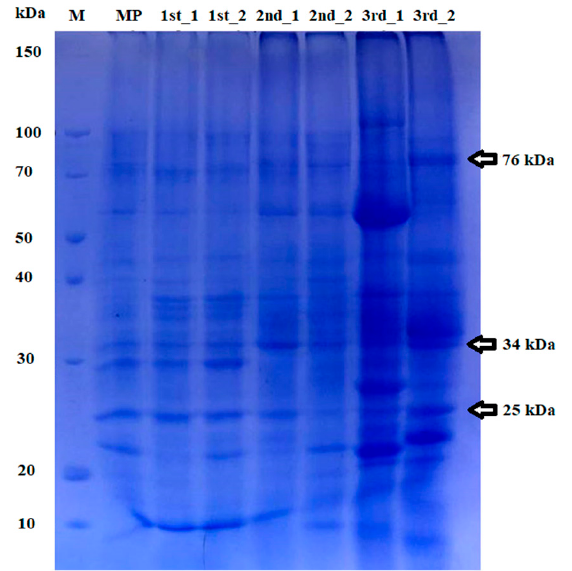
Figure 4. SDS-PAGE analysis of total protein bans extracted from three micropropagated generations of L. schweinfurthii compared to the mother plant. M, marker; MP, mother plant; 1st, first-generation plantlets; 2nd, second-generation plantlets; 3rd, third-generation plantlets showing three of the monomorphic polypeptides detected.